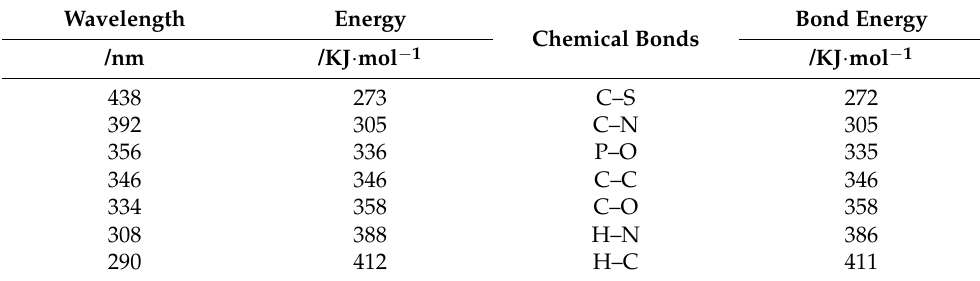
Table 2. The energy of the different wavelengths and the chemical bonds in